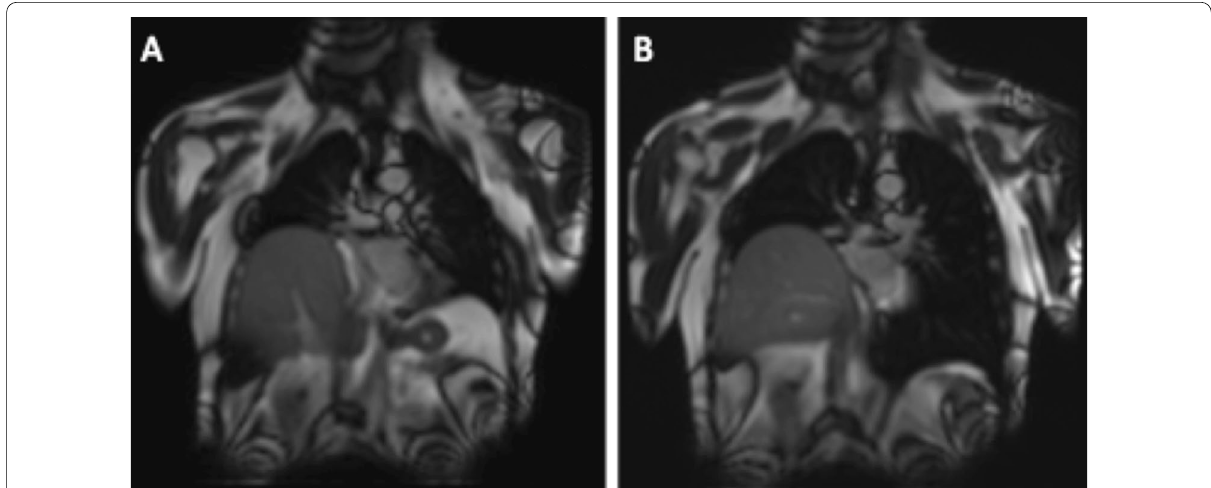
Fig. 15 Phrenic paralysis. Coronal MR dynamic images showing a right phrenic paralysis after right lower lobectomy. During exhalation ( A ), the two diaphragmatic domes are raised; during inhalation ( B ), the left dome is lowered while the right remains in place